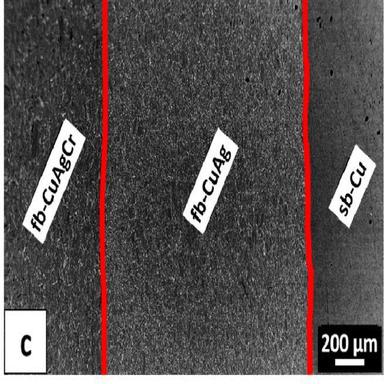
Interfaces of the (b) sub and middle layer, (a) middle and upper layer and (c) sub, middle and upper layer in same structure of FGM1.